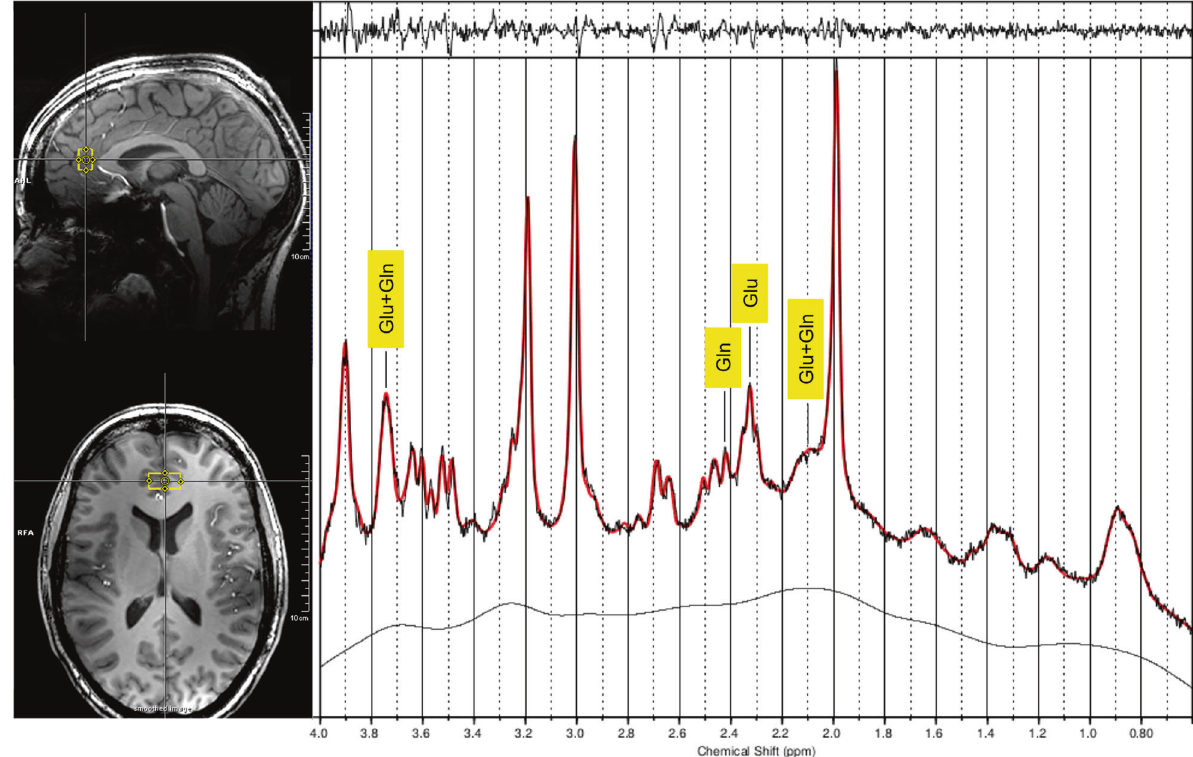
Fig. 2 Example voxel positioning in the pgACC and fi tted spectral curve using LCModel. As reported in Dou et al. [47], the pgACC voxel was positioned touching the genu of the corpus callosum while bypassing the callosomarginal artery. The bottom of the voxel was tilted into the anterior commissure-posterior-commissure plane and oriented using the sagittal projection line. Gln glutamine, Glu glutamate, MRS magnetic resonance spectroscopy, pgACC pregenual anterior cingulate